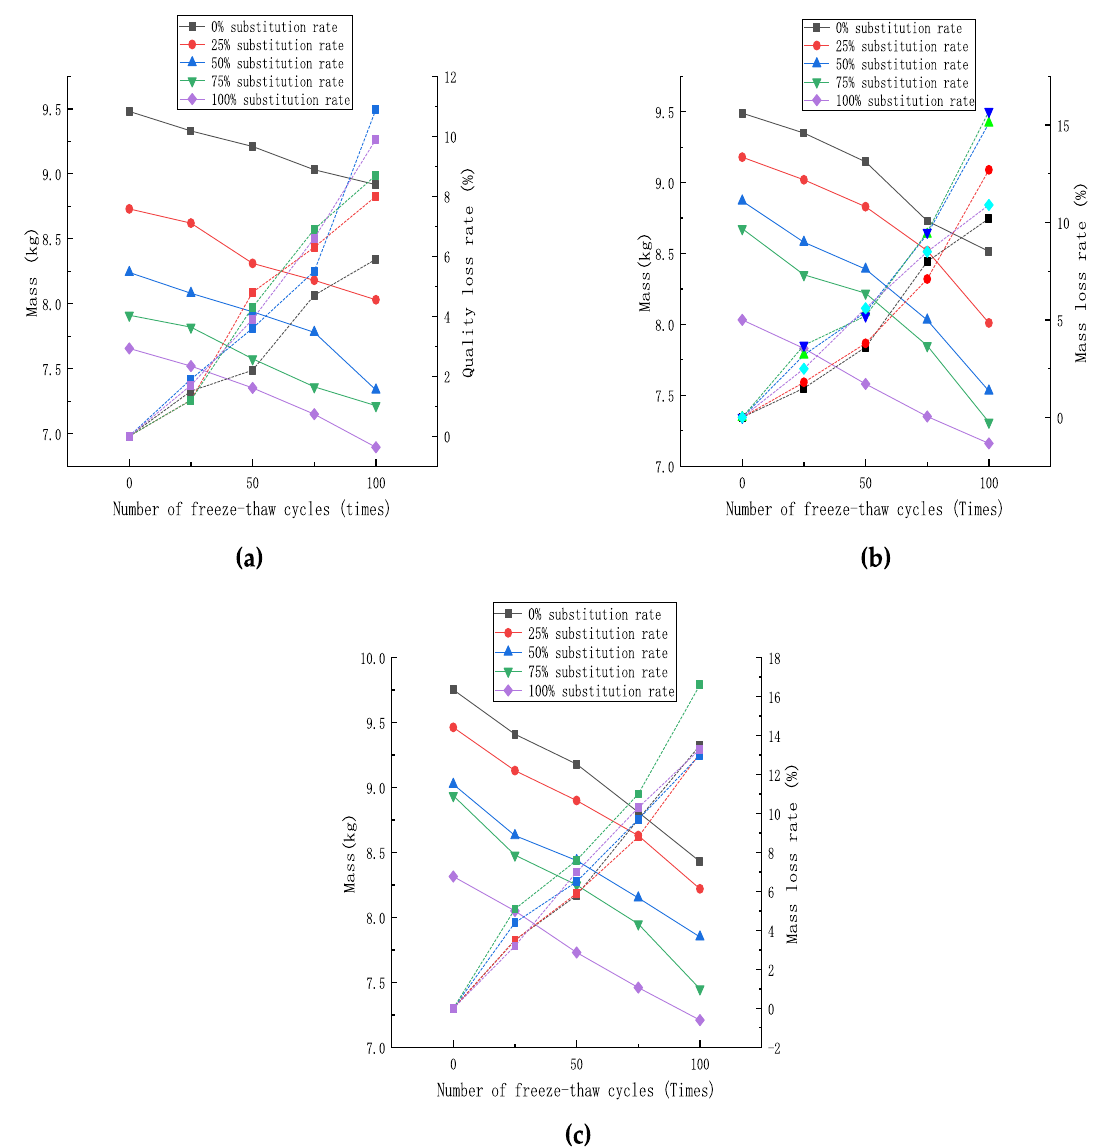
Figure 9. Specimens mass and mass loss rate: ( a ) steel fiber content 0%; ( b ) steel fiber content 1%; ( c ) steel fiber content